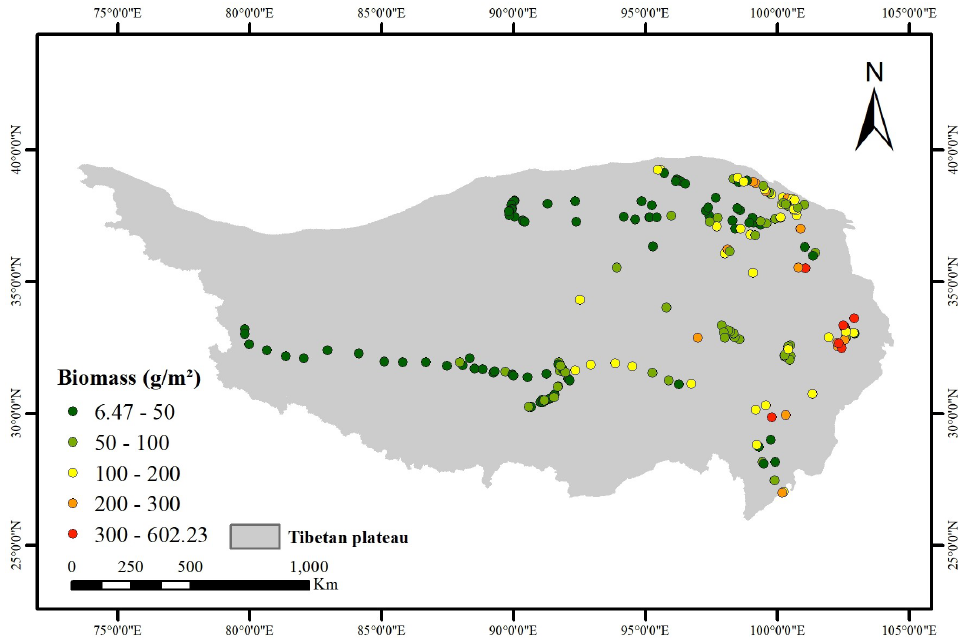
Figure 4. The spatial distribution of the measured grassland AGB values on the Tibetan Plateau during 2019 to 2021, including 218 sampling plots.